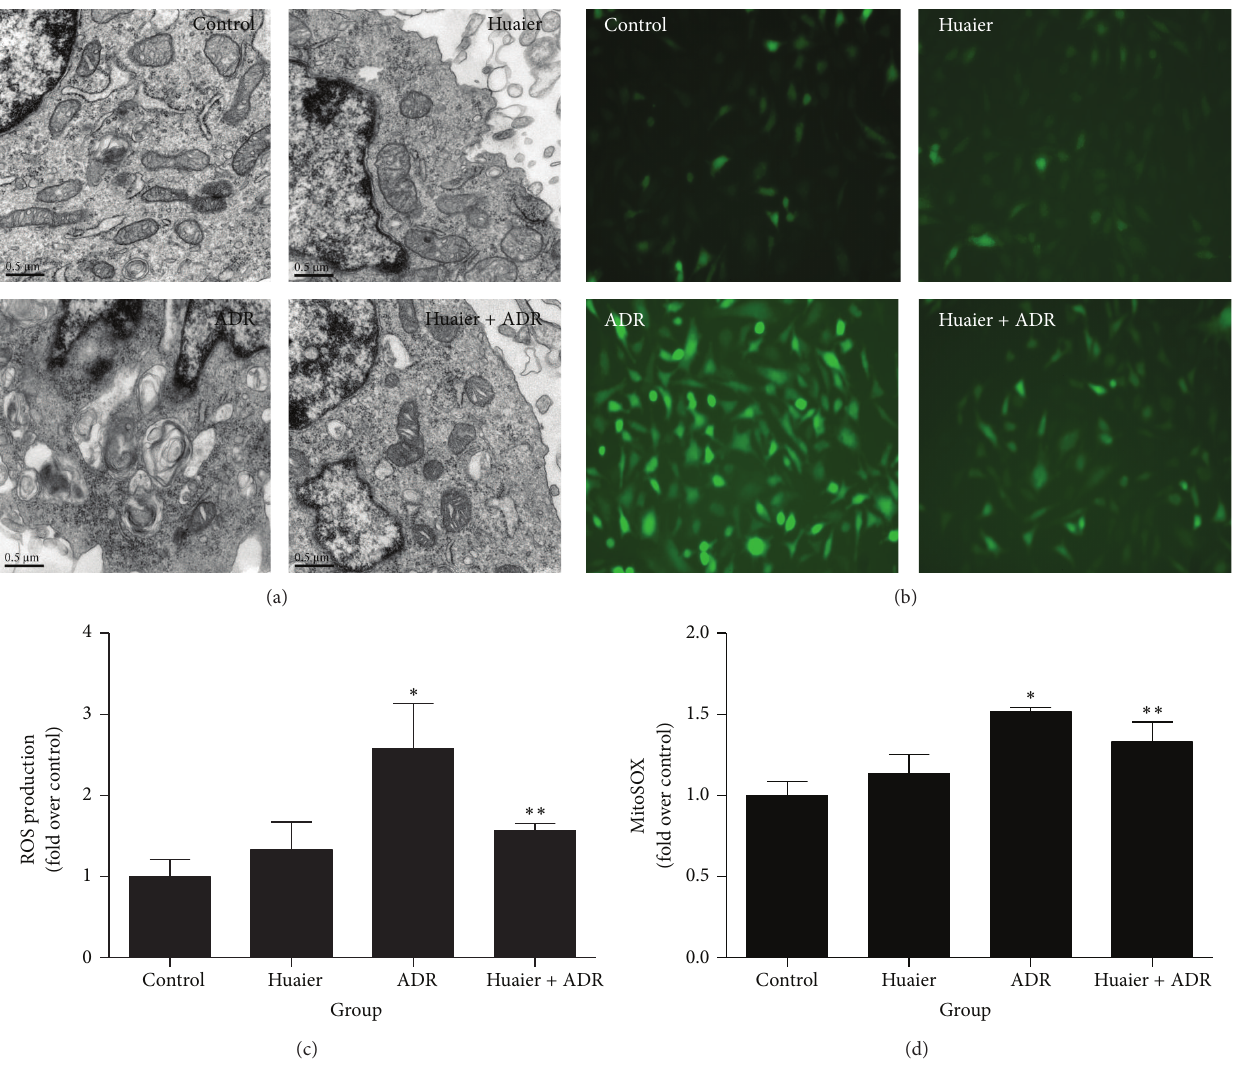
Figure 2: Huaier blocked ADR-induced mitochondrial dysfunction in vitro . (a) Mitochondrial morphology imaged by transmission electron microscopy. (b) Representative images of podocytes stained with dichlorodihydrofluorescein diacetate (DCFDA). (c) Quantitation of 2 󸀠 ,7 󸀠 - dichlorofluorescein (DCF) fluorescence by flow cytometry. (d) Quantitation of MitoSOX fluorescence by flow cytometry. Podocytes were pretreated with Huaier (0.2 mg/mL) for 1h followed by incubation with ADR (200 nM) for further 24 h. Data are expressed as the means ± SD ( 𝑛 = 6 ). ∗ 𝑃 < 0.05 versus control. ∗∗ 𝑃 < 0.05 versus ADR